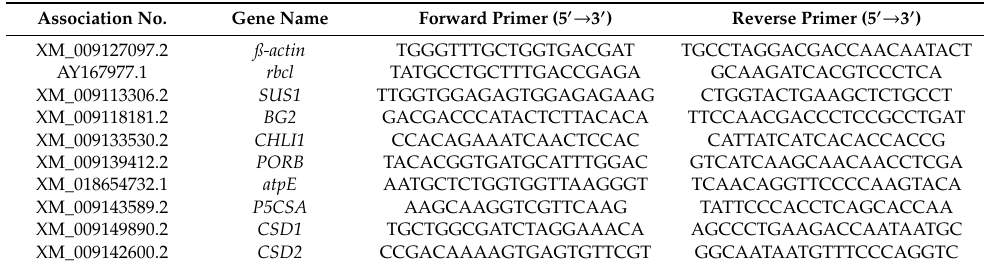
Table 3. Specific primers for di ff erentially expressed protein